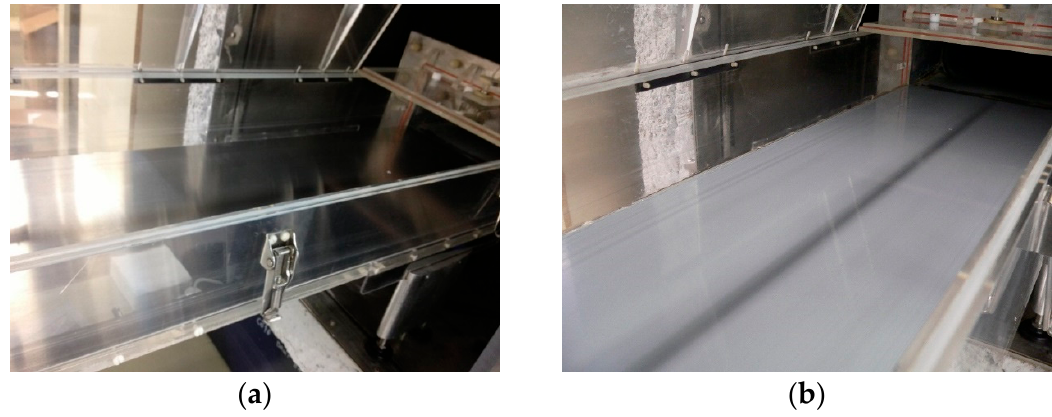
Figure 4. Aluminum plate installed on duct floor coated with ( a ) icephobic ( b ) epoxy.